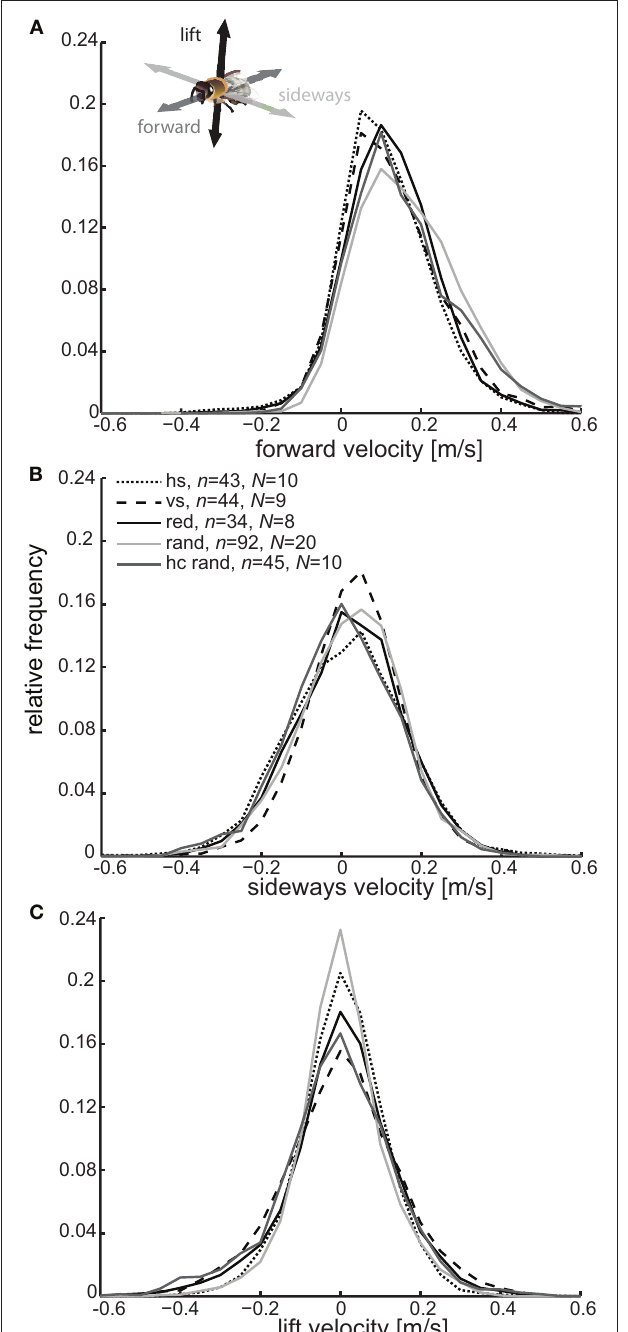
Figure 6 | Flight velocity close to the differently textured landmarks. The relative frequency histograms (bin size of 0.05 m/s) for the forward (A) , sideways (B) and lift (C) velocity for flights during training are shown for the different textures [horizontal stripes (dotted line, n = 43 flights, N = 10 bees), vertical stripes (dashed line, n = 44, N = 9), red (solid line, n = 34, N = 8), random dot pattern (light gray line, n = 92, N = 20) and the high-contrast random dot pattern (dark gray line, n = 45, N = 10)]. Only those parts of the flights where the bee was closer than 100 mm to the center of the labeled near landmark were taken into account. The proportion of time that bees fly with different velocities depends on the kind of landmark texture.